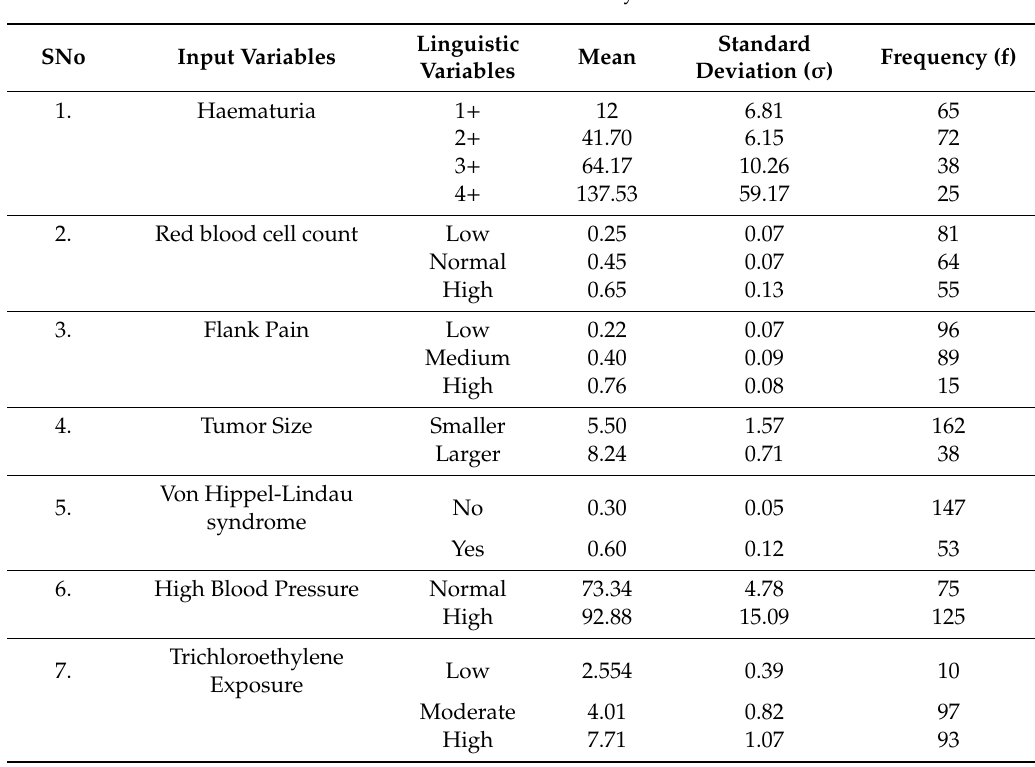
Table 5. Parameters of Layer 2.